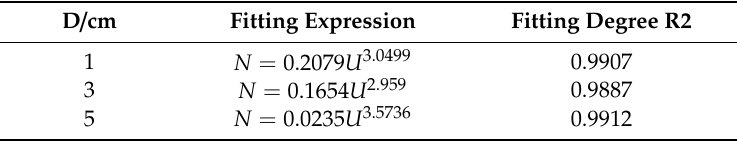
Table 1. Fitting of di ff erent needle-plate gap distance and UV pulse number.